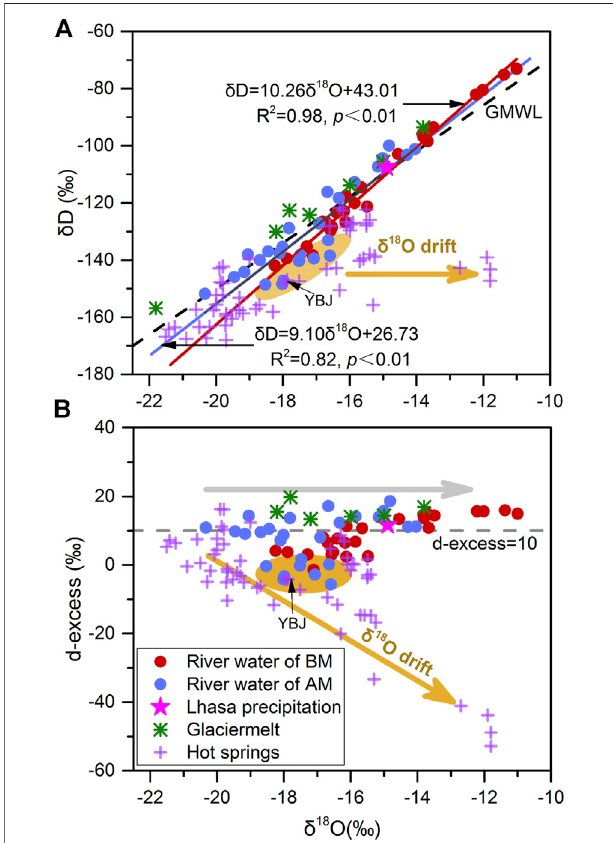
FIGURE 4 | δ D vs δ 18 O values and d-excess vs δ 18 O values for natural water in the YTR Basin. The red dots and blue dots represent the δ D vs δ 18 O values of river water sampled before the monsoon precipitation (BM series) and after the monsoon precipitation (AM series), respectively. The red line and blue line show the linear fi tting relationships between δ D and δ 18 O values of BM series and AM series river water, respectively. The black dashed line in (A) is the Global Meteoric Water Line (GMWL, δ D (cid:1) 8 δ 18 O+10) (Craig, 1961). The gray dashed line in (B) is d-excess (cid:1) 10 ‰ . The brown arrow shows the downward trend of δ 18 O drift in the groundwater; the gray arrow shows the distribution trendofglobalmeteoric water. The δ D and δ 18 O values of glacier melt and groundwater are from Ren et al. (2017b), Tan et al. (2014), Tan et al. (2021), and Liu et al. (2019), respectively.